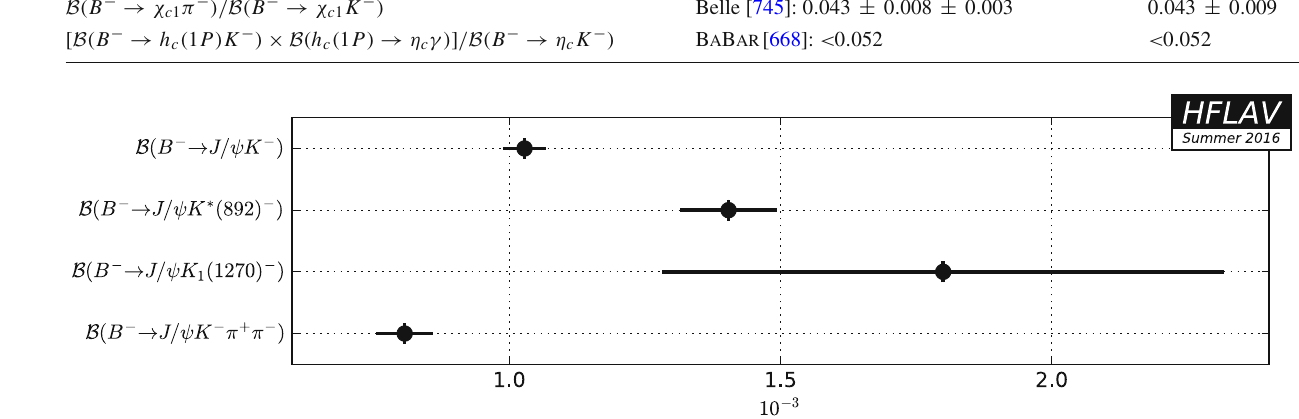
Fig. 128 Summary of the averages from Table 159